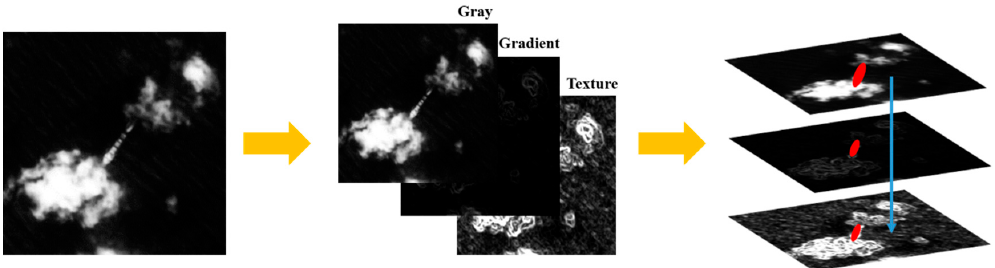
Figure 8. Procedure of generating a synthetic image.